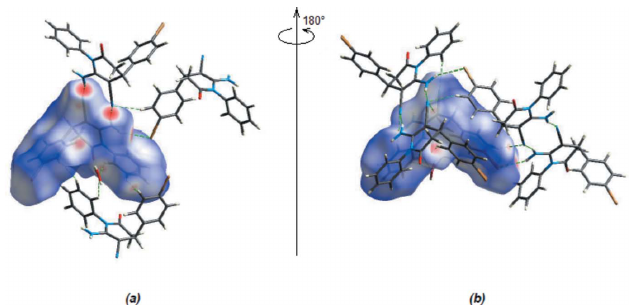
Figure 6 ( a ) Front and ( b ) back views of the Hirshfeld surfaces mapped over d norm for (I).